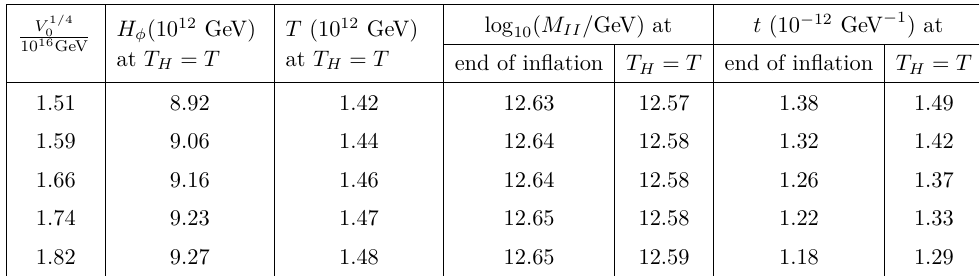
= T for comparison. H H